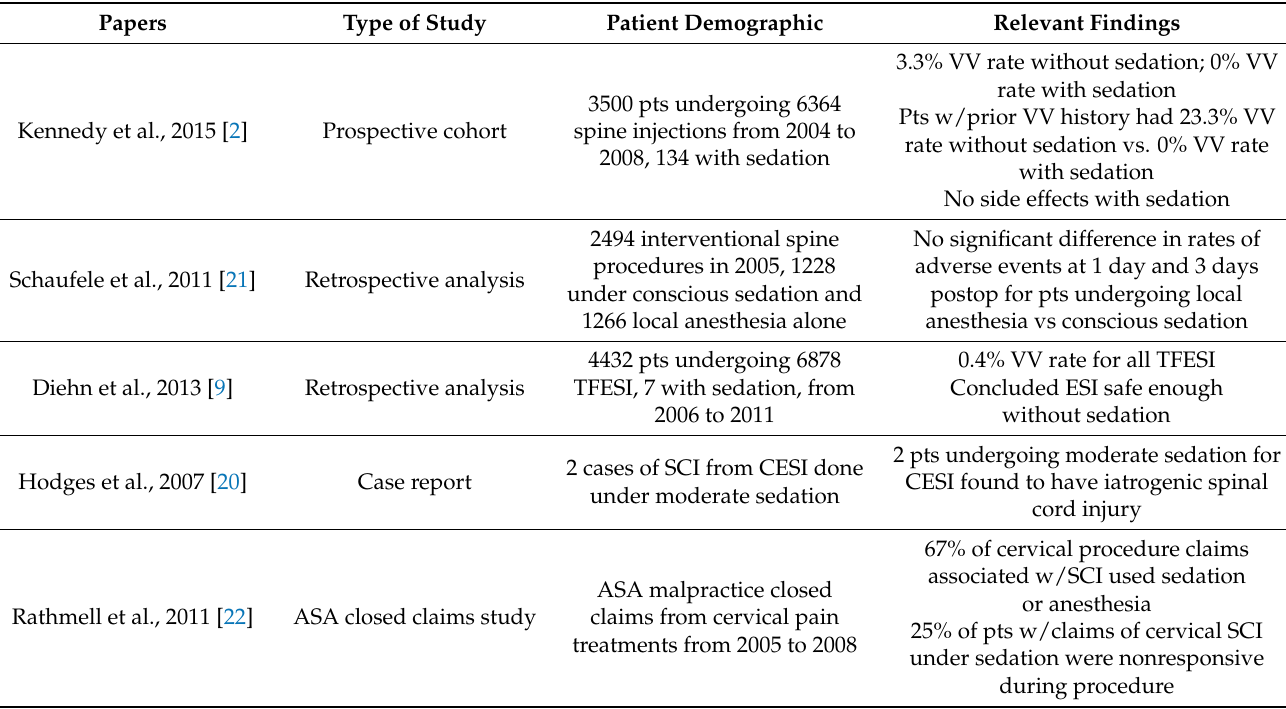
Table 3. Sedation during interventional pain management